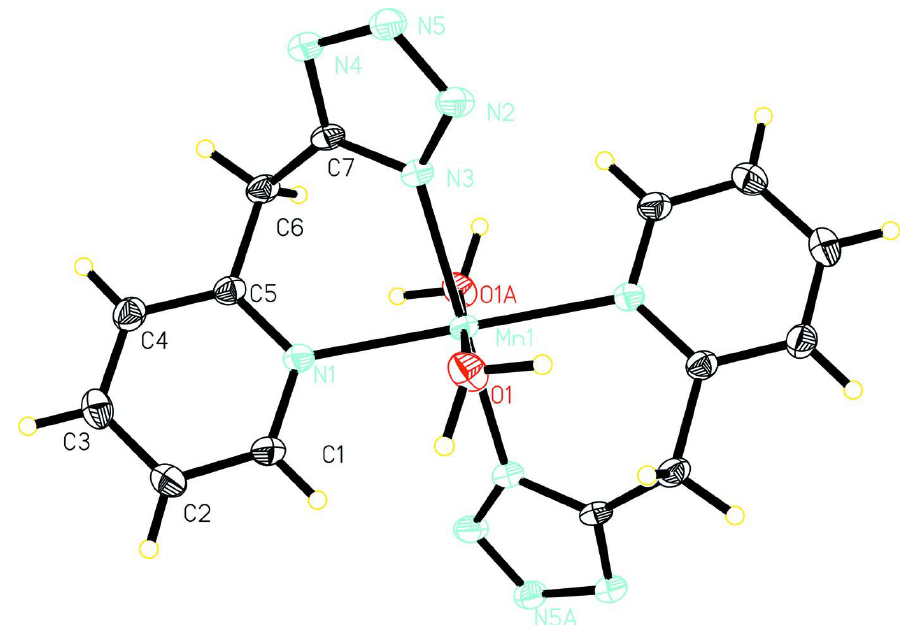
Figure 1 The molecular structure of the compound with the atomic numbering scheme. Displacement ellipsoids were drawn at the 30% probability level. [symmetry code: -x, -y+2, -z+2]